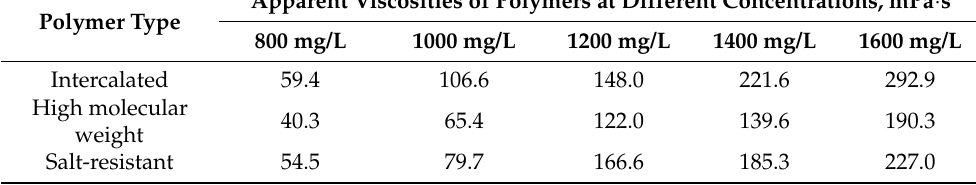
Table 1. Thickening effect of the intercalated polymer in water.